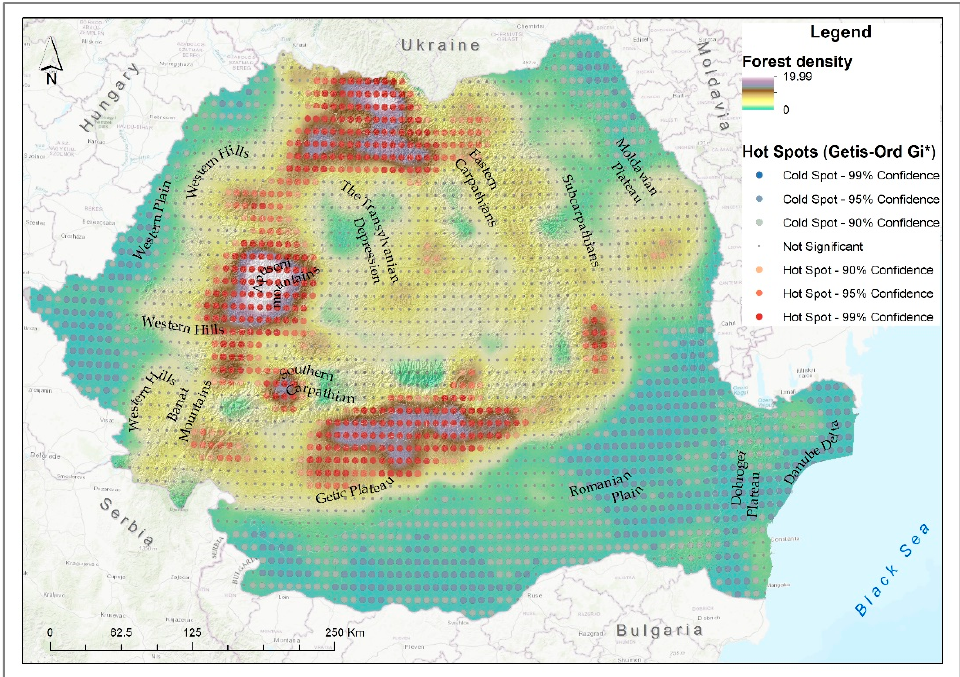
Figure 4. Forest degraded ecosystem density and hotspot analysis.